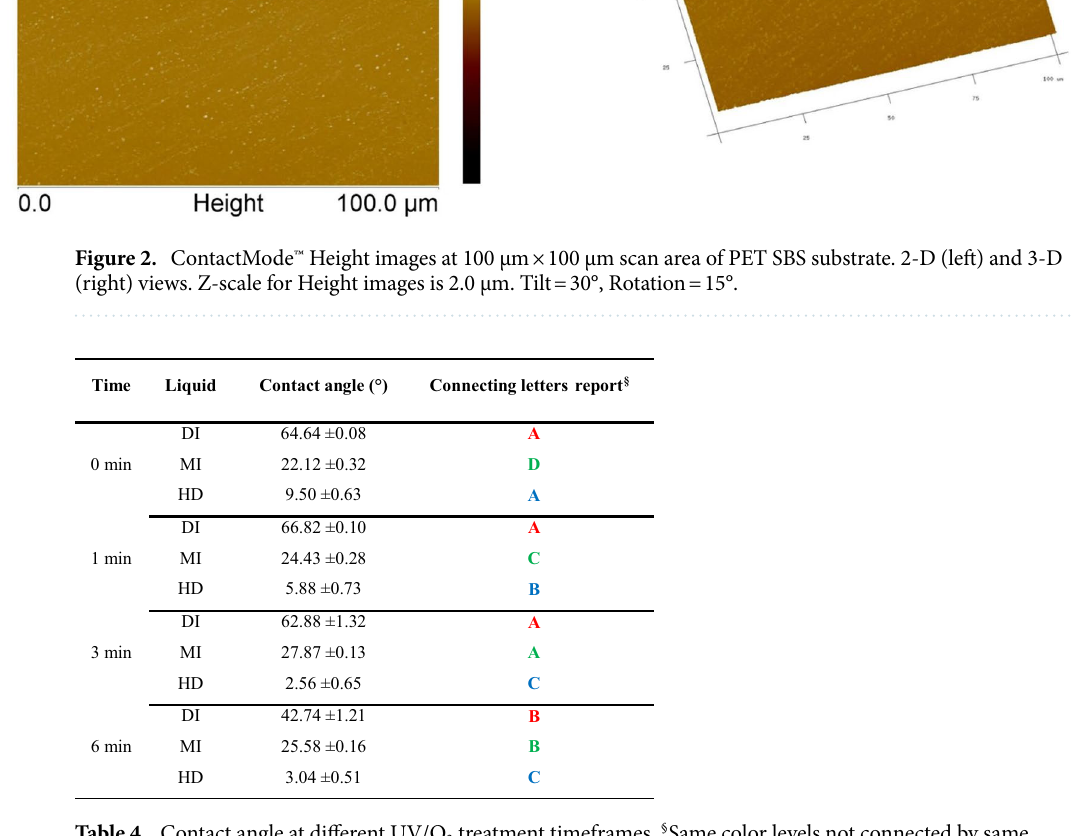
Table 4. Contact angle at different UV/O 3 treatment timeframes. § Same color levels not connected by same letter are significantly different. ABCD lists the values from highest to